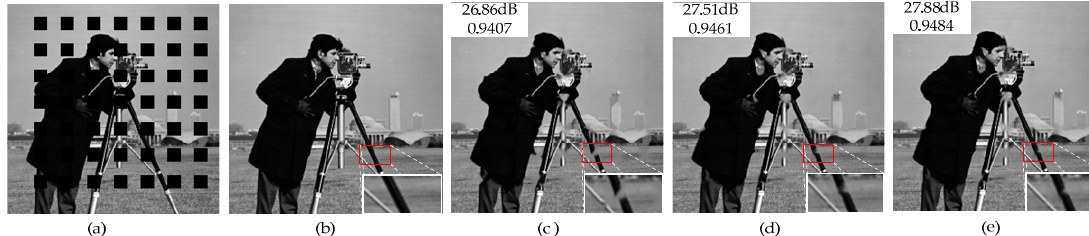
Figure 16. Subjective quality comparison of the proposed correction and adaptive scan order on the Cameraman image with 16 × 16 regular isolated loss. The reconstructed details are shown in the lower right corner of each image. ( a ) The received image. ( b ) The original image. ( c ) The reconstructed image with scenario ‘Cor(off)-Ord(on)’. ( d ) The reconstructed image with scenario ‘Cor(on)-Ord(off)’. ( e ) The reconstructed image with scenario ‘Cor(on)-Ord(on)’.